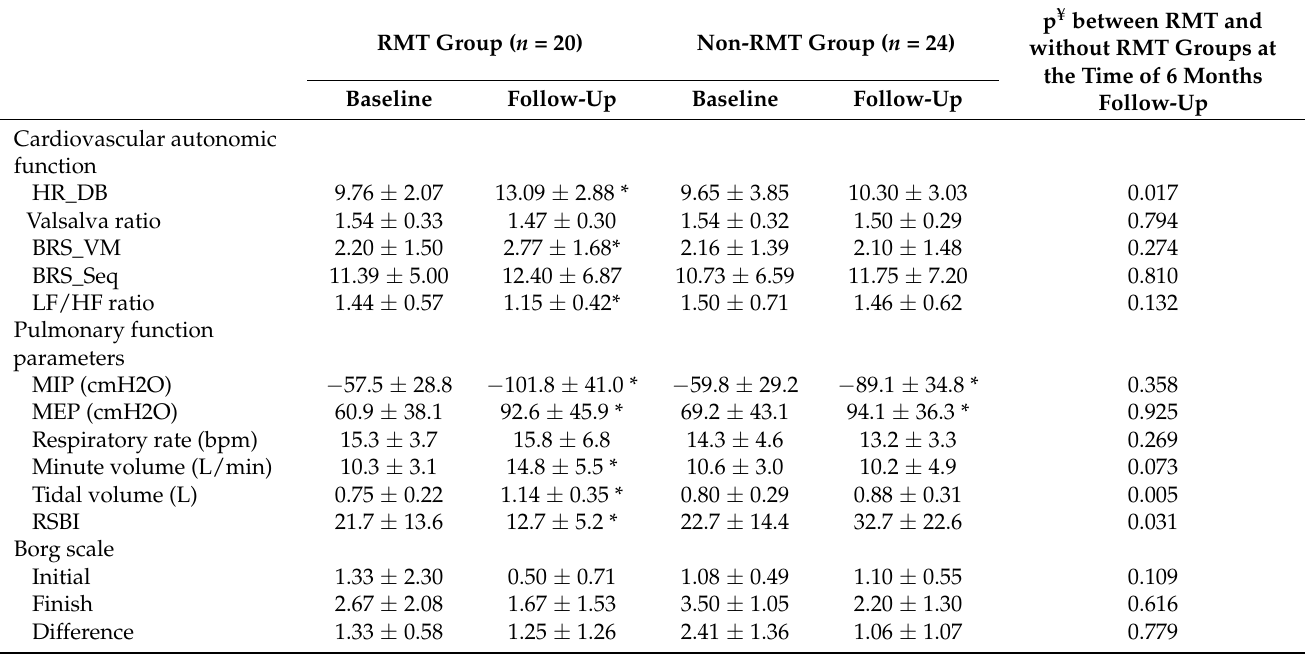
Table 2. Changes in cardiovascular autonomic function and pulmonary function between groups of patients with RMT and without RMT during the study period. RMT Group ( n =